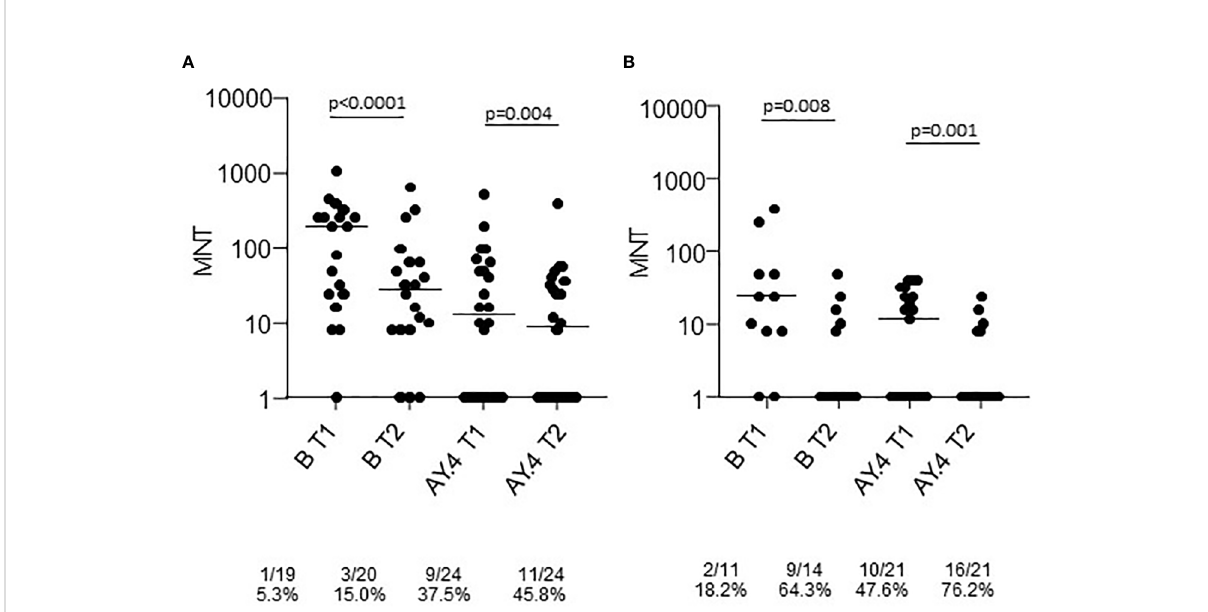
FIGURE 2 Microneutralization titers of T1 and T2 sera from COVID-19 naïve subjects vaccinated with Comirnaty. Sera from healthy adults (A) and frail elderly subjects (B) vaccinated with the Comirnaty vaccine were used to neutralize reference SARS-CoV-2 strain (B) and a Delta strain (AY.4). Individual MNT are reported together with median values. Non-neutralizing sera (MNT<8) are placed on the x-axis; frequencies of non- neutralizing sera are indicated below the graphs. Statistical differences among strains were calculated by the Kruskall-Wallis test; differences among time-points were calculated with the Wilcoxon